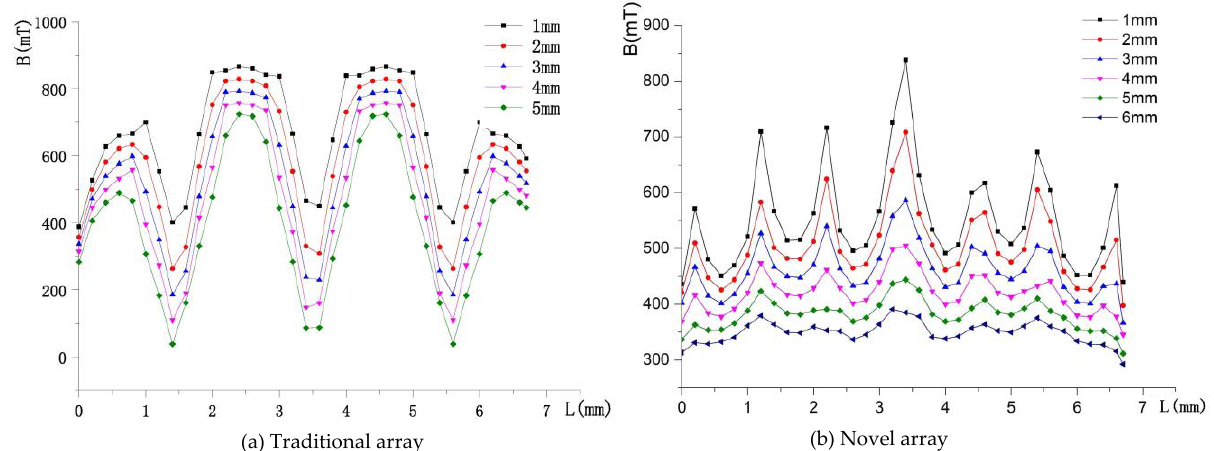
Figure 10. Air gap flux density distribution of the two schemes.